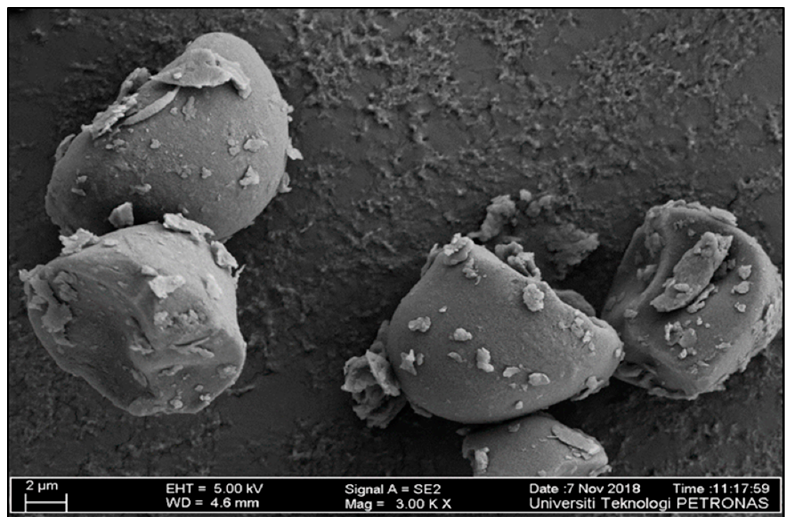
Figure 4. Scanning electron micrograph of cassava peel powder.